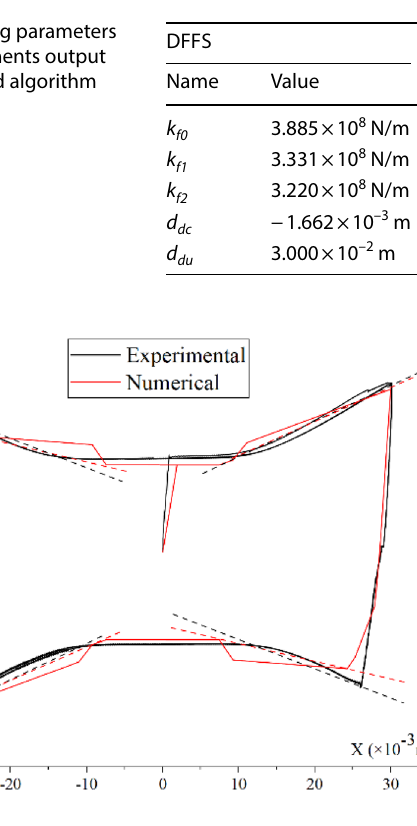
Fig. 16 Hysteresis of super-link defined by product-wise optimized parameters